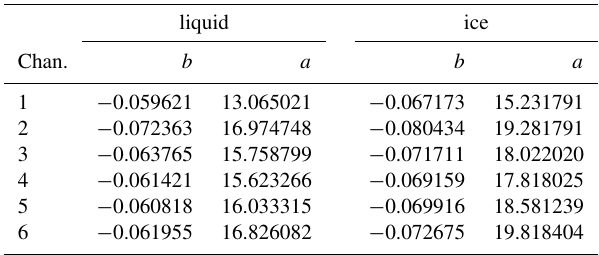
Table 1. The empirical coefficients for the Tb to RH transformation method for SAPHIR channels.